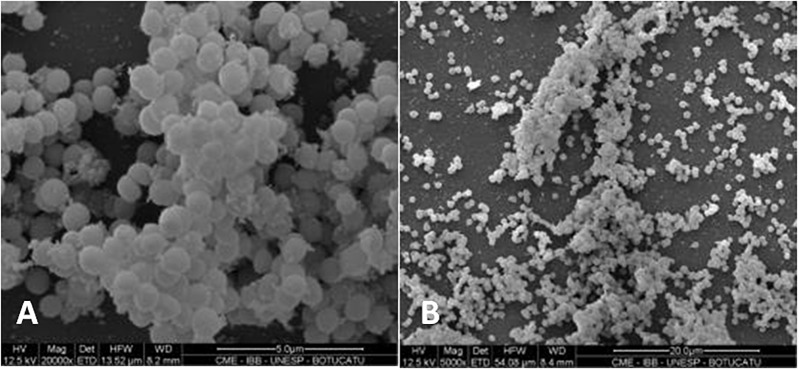
Scanning electron micrograph showing the biofilm structure in Staphylococcus saprophyticus. Magnification: (A) 20,000×; (B) 5,000×.